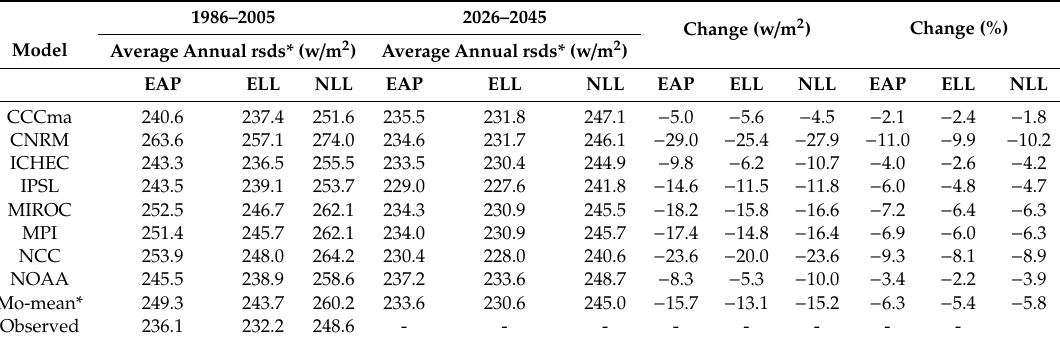
Table 6. Changes in annual solar irradiance